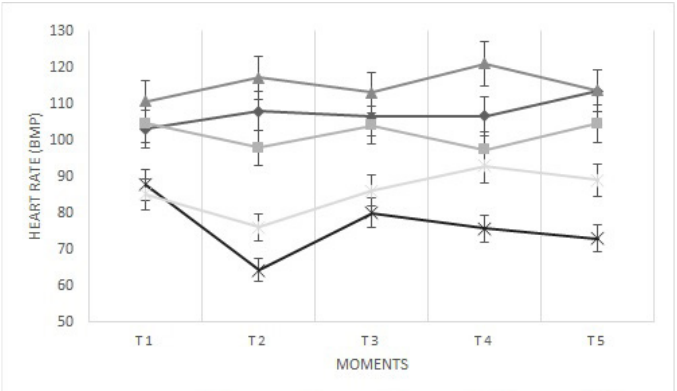
Figure 3. Heart Rate (BPM) relative to the groups and moments under study (before PAM, after anesthetic